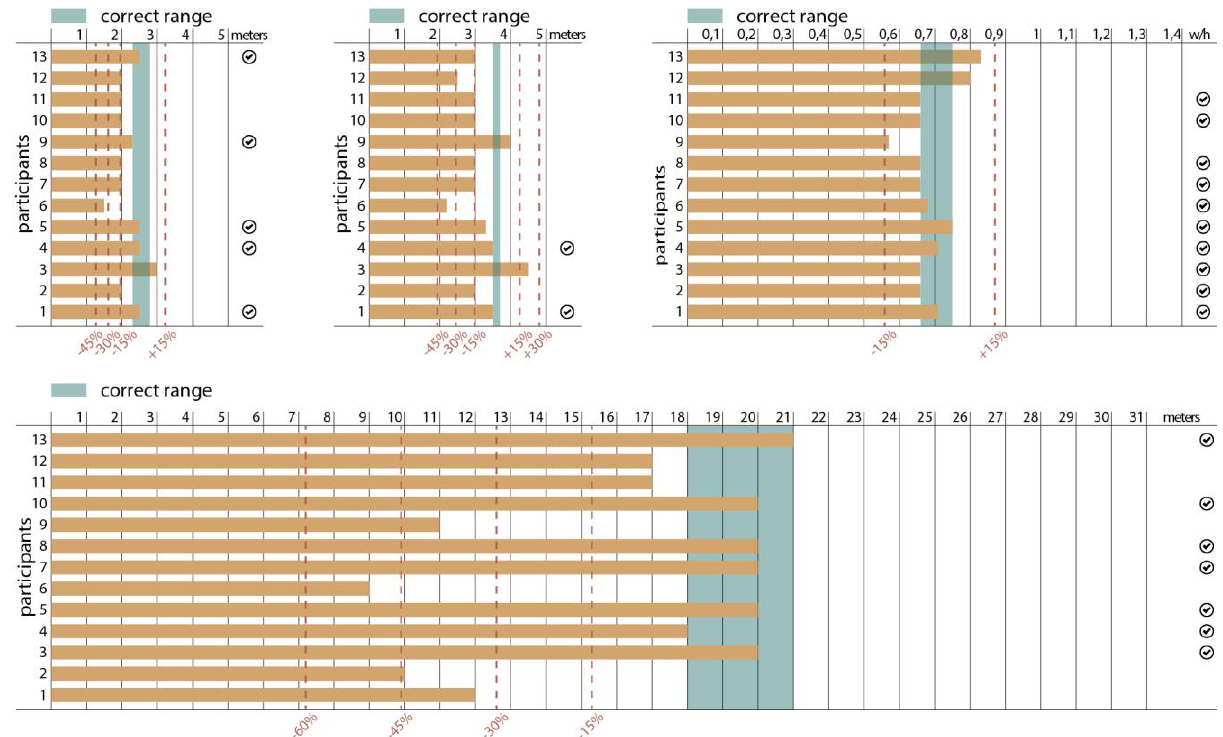
Figure 15. Dimensions estimated by the participants. Width, Height and W/H (top), Length (bottom)